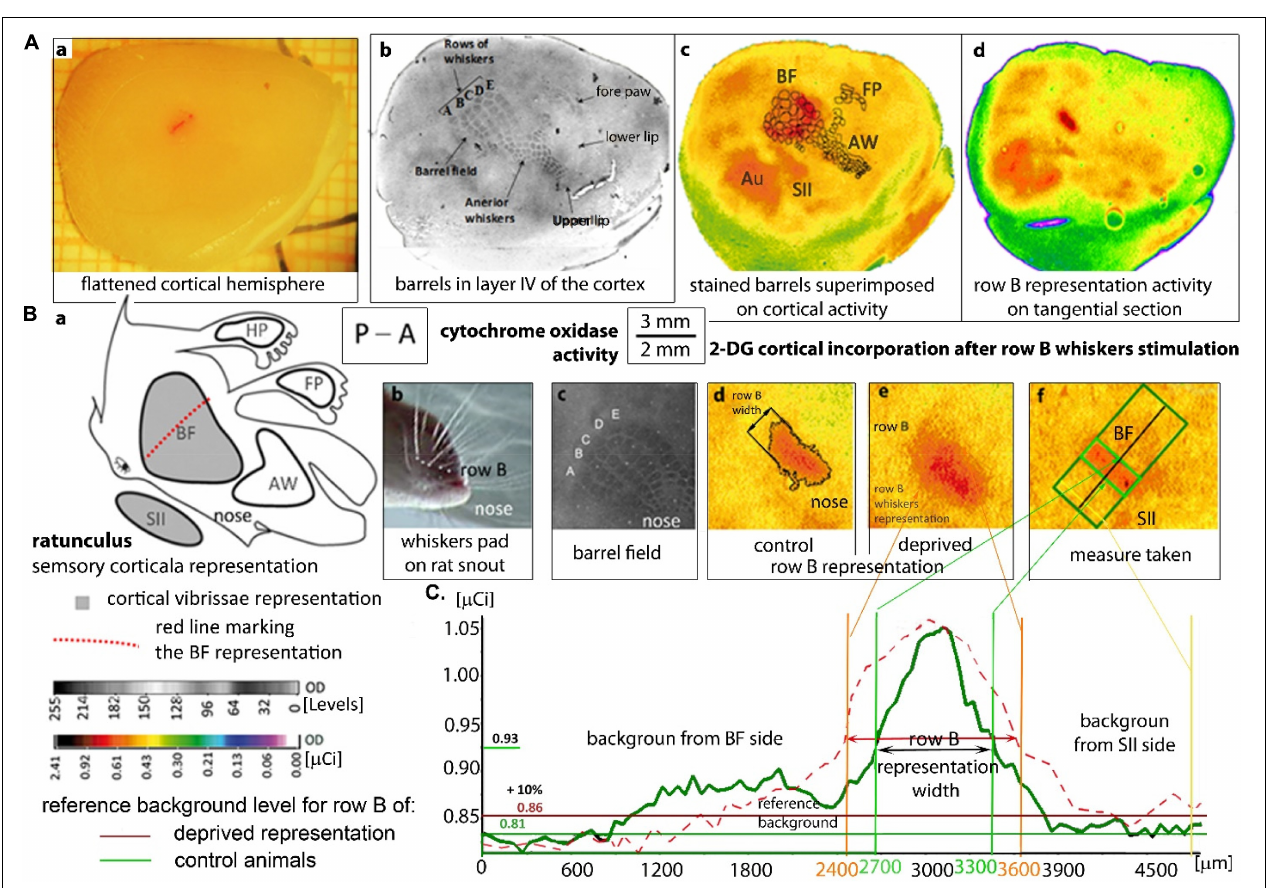
FIGURE 1 | Localization and measurement of the row B cortical representation: (A) A flatted hemisphere and tangential sections of the cortex after 2DG brain activity mapping. (A,a) Isolated hemisphere with a marked line perpendicular to the representation in row B. Localization of the rats’ cortical whiskers somatosensory representations on a tangential section of layer IV (A,b–d) stained by cytochrome oxidase activity (A,b) and 2DG-incorporation on autoradiograms visualizing the brain activity (A,c,d) . (A,c) Superimposed barrels from the histological staining to the suitable autoradiogram image which is shown in pseudocolors. (A,d) : the autoradiogram presenting stimulated row B activity. (AW) anterior whiskers representation; (FP) front paw representation; (SII) secondary somatosensory cortex, (Au) auditory cortex which is always activated by the white noise. The left whiskers stimulation in intact rats activates, the right BF and SII (A,c) in the contralateral hemisphere and do not activate AW, hind paw and FP cortical representations (A,c,d) . (B) The cortical vibrissal representation in SI and SII. (B,a) “Rattunculus” with areas of increased activation during all whiskers stimulations marked in gray. (B,b) Photograph of the whiskers pad on the rat snout showing row B. (B,c) Magnification of the barrel field on the cortical tangential section stained for cytochrome oxidase activity. (B,d,e) A magnification of row B cortical representation on digitized autoradiograms of tangential sections in undeprived (B,d) and deprived (B,e) animals. (B,f) Row B representation with the marked area of the width measured with the rotatable box. (C) Comparison of the OD graphs showing 2DG incorporation from the animals with non-deprived (green line) and deprived BF (dashed red line). OD analysis by the MCID program, where the area exceeding the background over 10% were treated as the activated representation of row B.